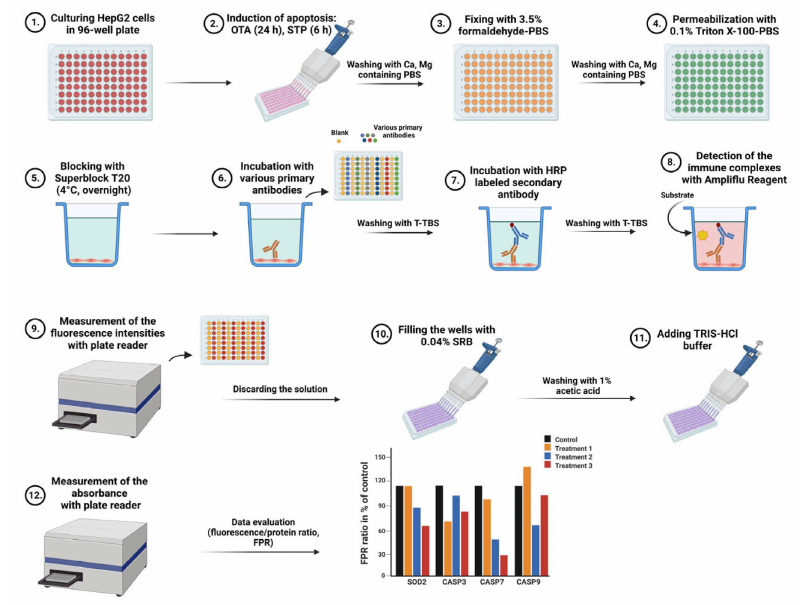
Figure 8. Flow chart ofthe multiplexed in situ protein expressionmethod. “Createdwith BioRender.com”.